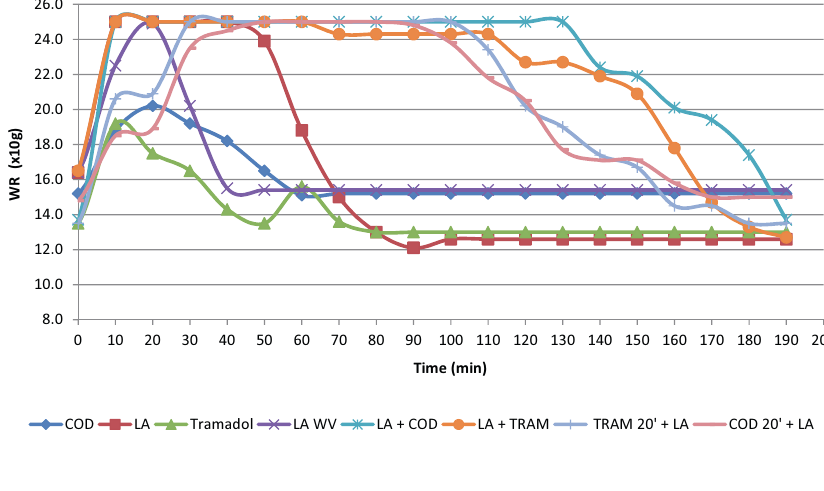
Figure 4 - Values for motor reflex (claudication). (1) normal function, (2) partial function, (3) absent